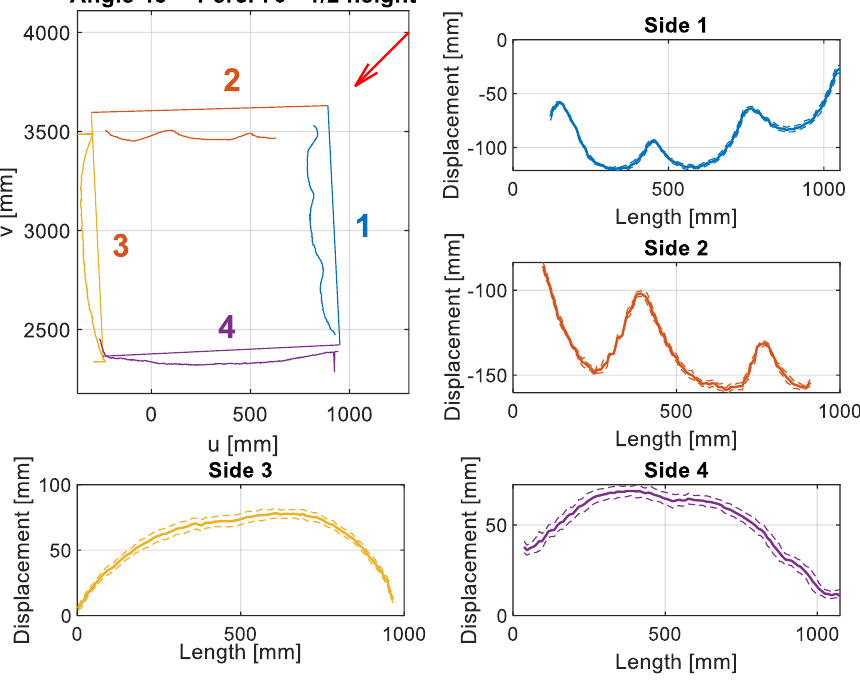
Figure 8. Example of the analysis performed for the squared structure of section at ½ of total height at wind speed of 158.5 km/h. The wind direction is indicated by the red arrow.